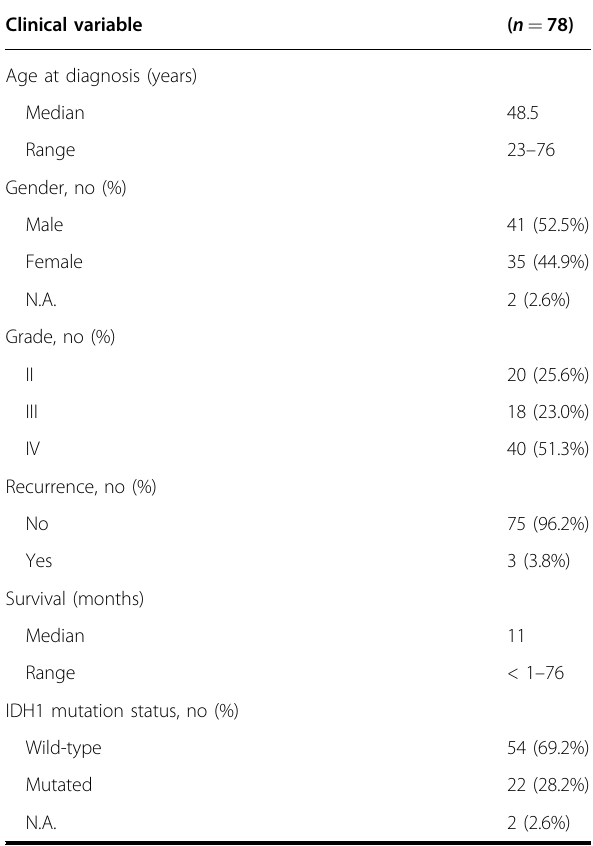
Table 1 Clinical characteristics of patients. Clinical